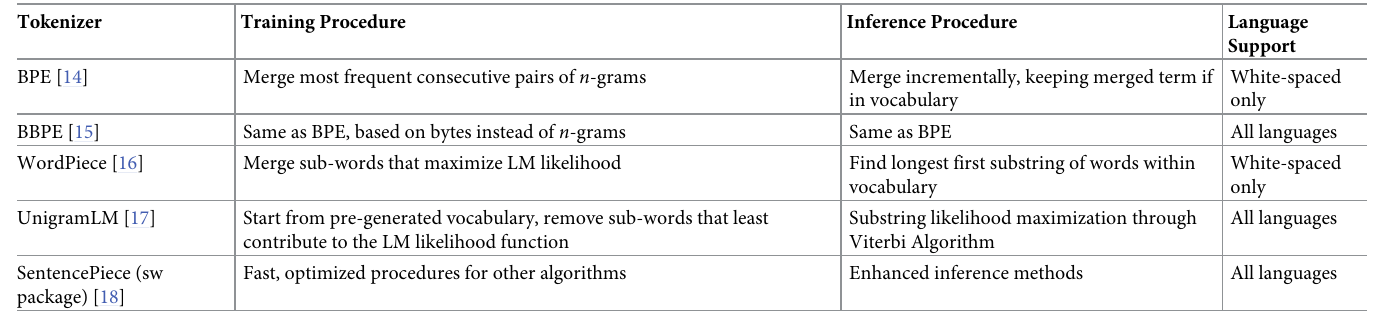
Table 1. Most widely adopted recent tokenization